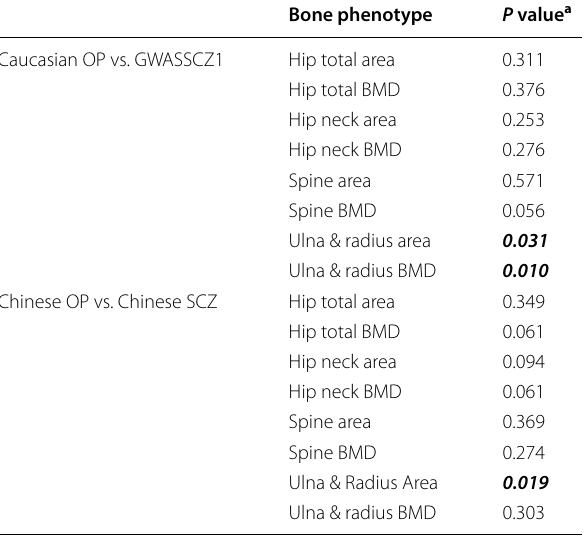
Table 1 PRS analysis results of BMD, bone area and